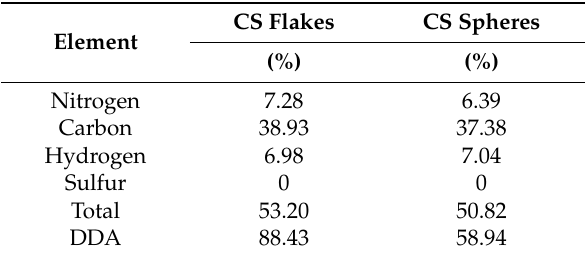
Table 3. Elemental analysis for CS flakes and CS spheres.